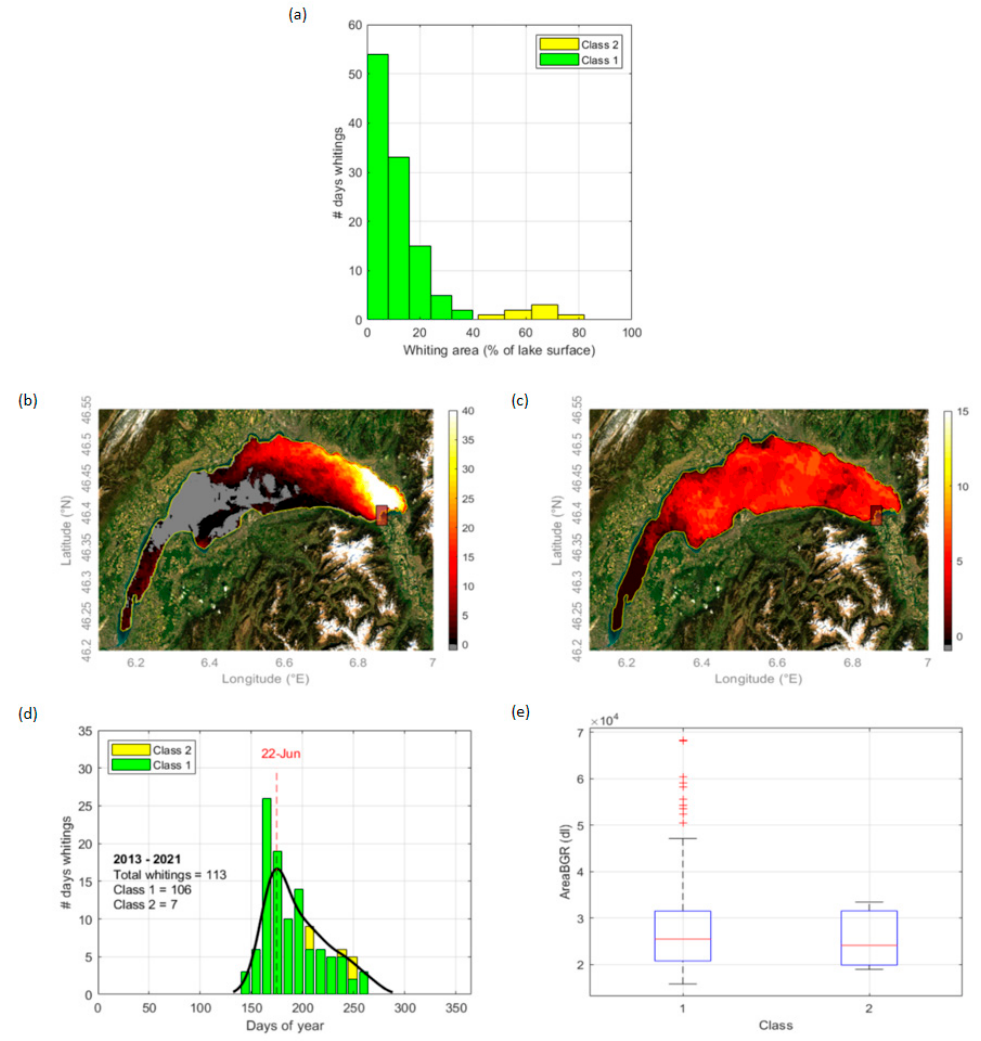
Figure 4. ( a ) Distribution of whiting by areal coverage. Whitings with areas <40% of the surface of the lake (class 1) and whitings with areas >40% of the lake (class 2). ( b , c ) Maps of spatial occurrences of observed whiting days of class 1 ( b ) and the whitings of class 2 in Lake Geneva from 2013 to 2021 ( c ). ( d ) Temporal distribution of whiting days (both class 1 (green) and class 2 (yellow) are stacked) are expressed as a function of the day of the year of occurrence. The black line is the kernel fit. The date of the peak distribution is shown in red. ( e ) Boxplots of the AreaBGR index values for whitings of classes 1 and 2. The median value is shown in red, and the top and bottom edges of the box show the 25th and 75th percentiles. The black whiskers show extreme values, and the red crosses show outliers.